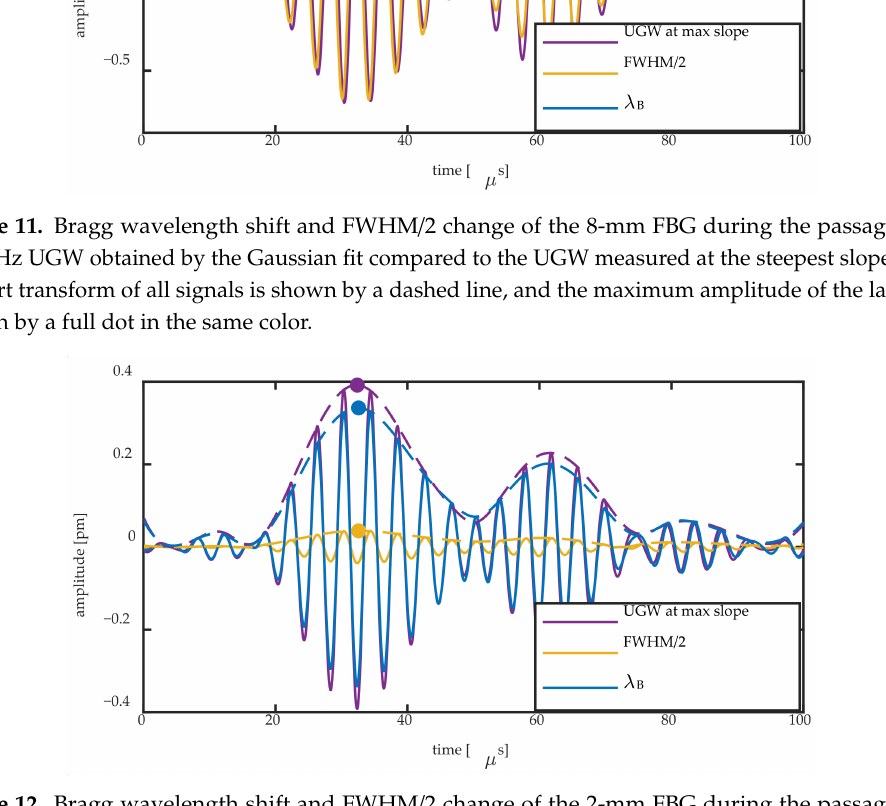
Figure 12. Bragg wavelength shift and FWHM / 2 change of the 2-mm FBG during the passage of a 250 kHz UGW obtained by the Gaussian fit compared to the UGW measured at the steepest slope. The Hilbert transform of all signals is shown by a dashed line, and the maximum amplitude of the latter is shown by a full dot in the same